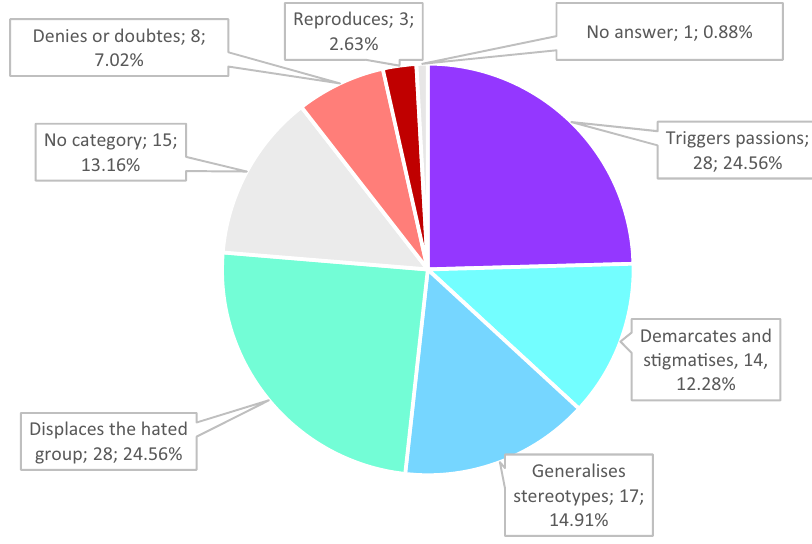
Fig. 1 Future teachers identifying hate speech. Results of activity 1 classi fi ed by